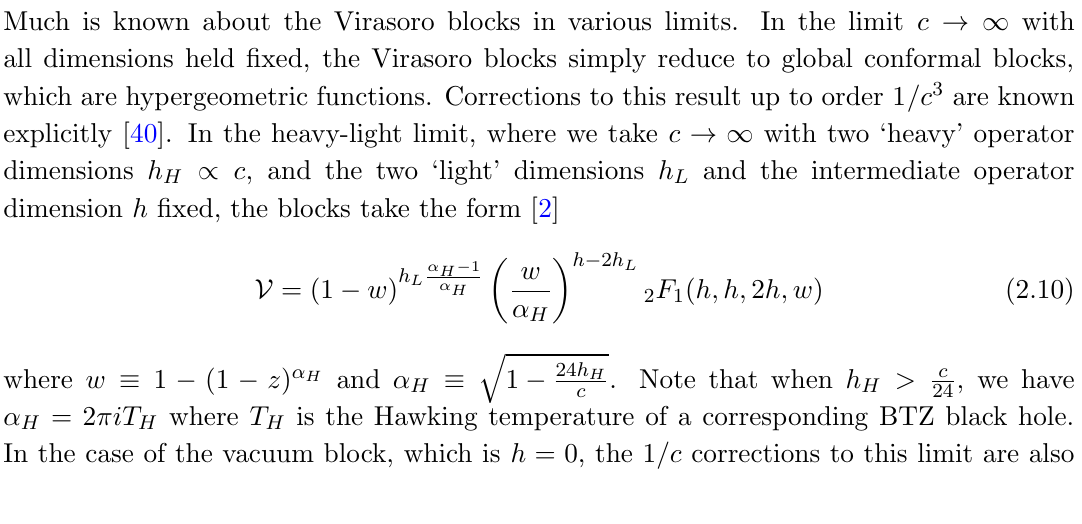
Figure 6 . The function q ( r; t ) for di(cid:11)erent r , where we have written z = 1 lines t [0 ; ). For the blue curve we chose (cid:12) = 2 (cid:25) , which corresponds with h H = c 2 1 the wiggles are due to the fact that when t = 2 (cid:25)n and r singularity. The large time limit of q was given in equation